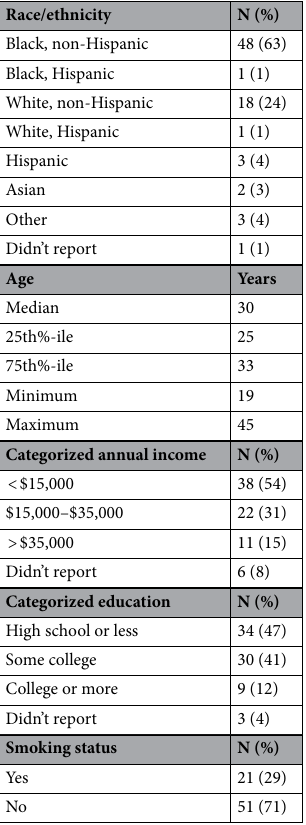
Table 2. Demographic characteristics of research participants in this